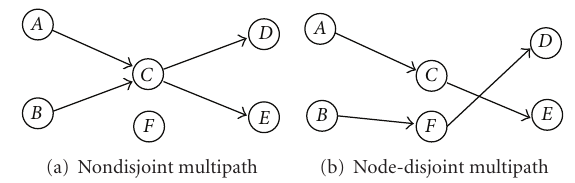
Figure 6: Influence of node-disjoint routing on link scheduling in [2].